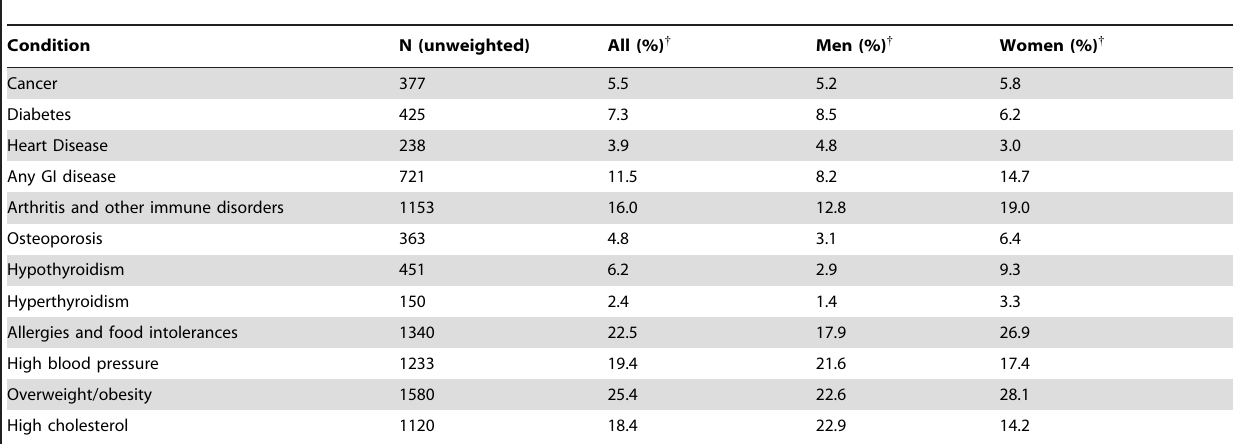
Table 2. Self-reported medically diagnosed chronic conditions* of CCM respondents (N =5,494), weighted to be representative of the Canadian population {